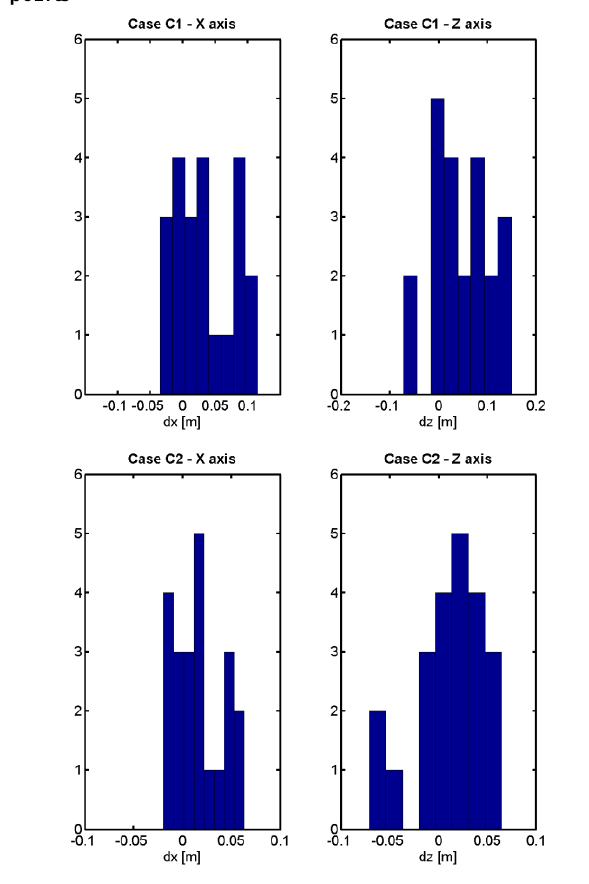
Figure 3. Case C: Histogram of residuals on the 22 check